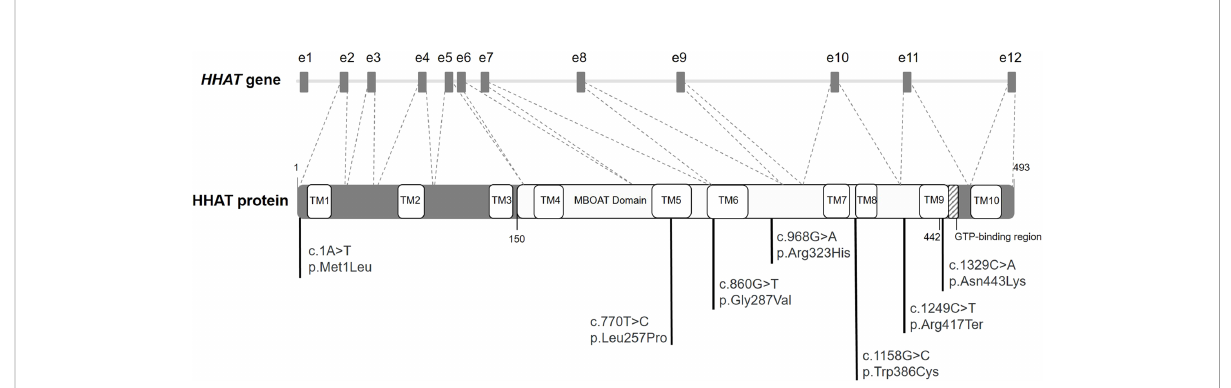
FIGURE 1 Diagram of HHAT gene and protein. Diagram of HHAT gene (NC_000001.11) with the boxes indicating the 12 exons (e1 to e12). The coding DNA sequence (NM_018194) from e2 to e12 codi fi es for HHAT protein (striped lines). Diagram of the HHAT protein isoform NP_060664.2 with its different domains and localization of the previously described variants in literature. The membrane-bound O- acyltransferase (MBOAT) domain encompasses amino acids 150 to